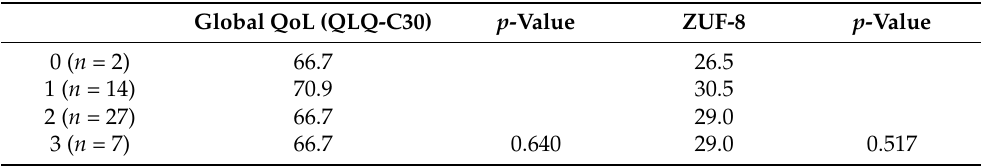
Table 1. Median global QoL and patient satisfaction in dependence of the highest-graded chronic toxicity according to CTCAE (Common Terminology Criteria of Adverse Effects) version 5.0. p -values are derived from Kruskal-Wallis tests.